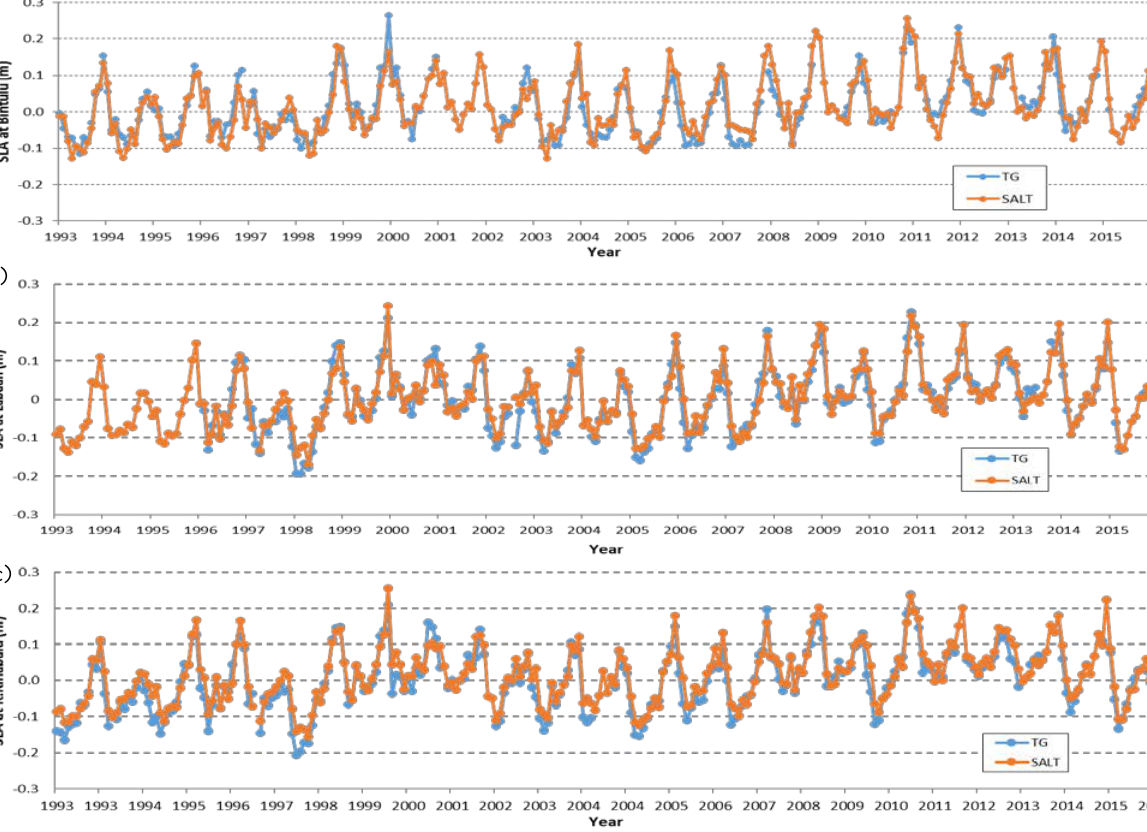
Figure 7. Sea level comparison between altimetry and tidal data at the Bintulu (a), Labuan (b), K. Kinabalu (c) of Sabah and